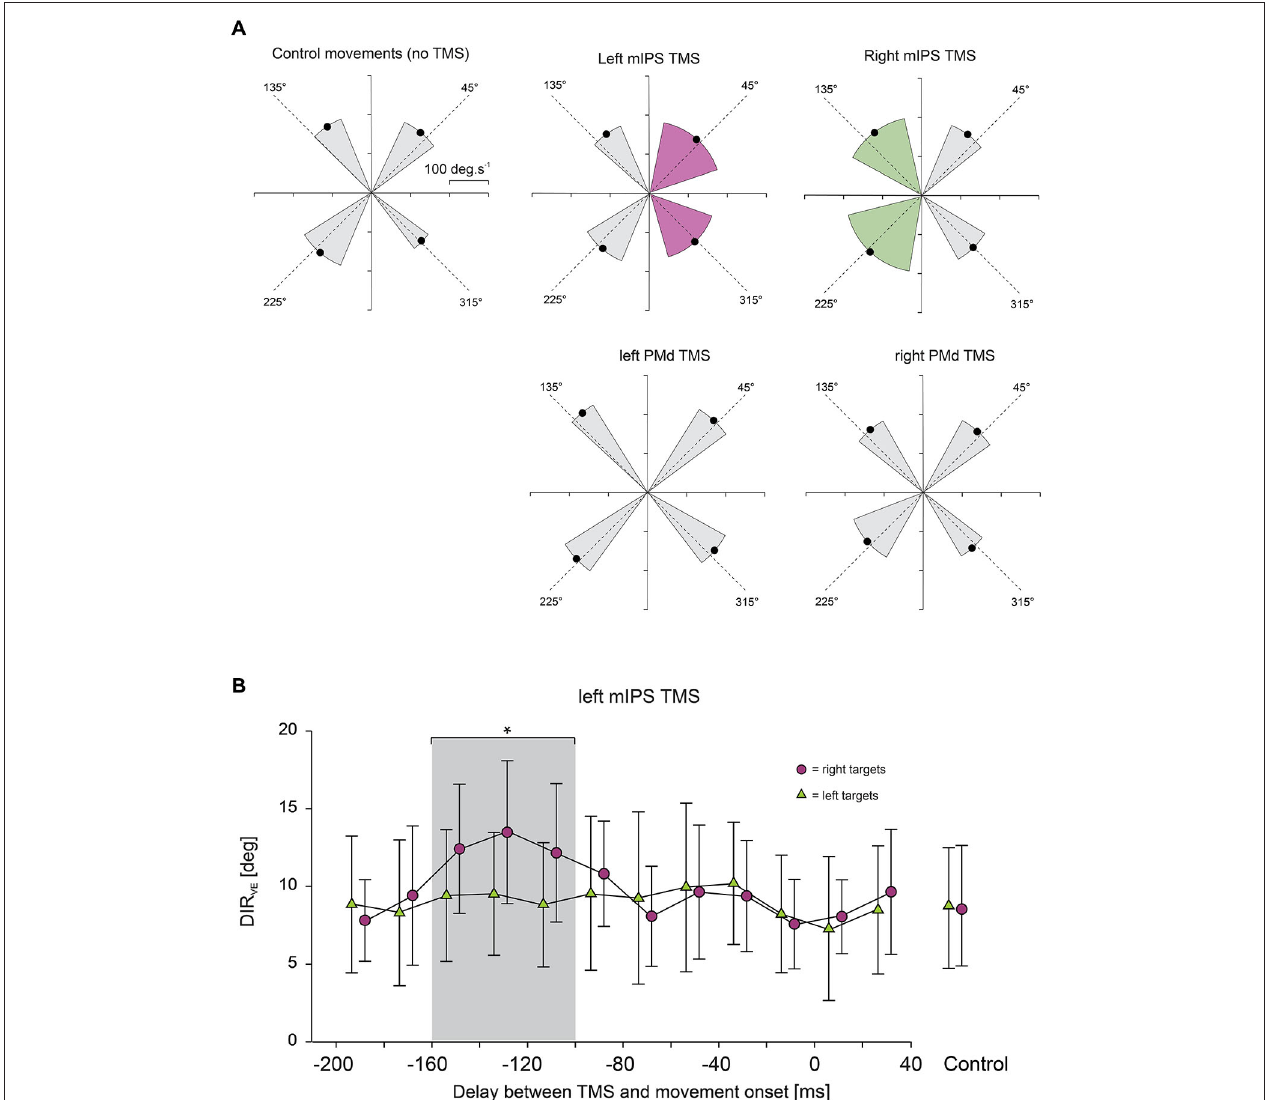
significant effect, namely 160–100 ms). PMd TMS had no effect on the initial movement direction when compared to control (no TMS). (B) Time course of the effects of left mIPS TMS on the initial movement direction (DIR VE ). Data were assigned to bins of 20 ms width (see Methods). X -axis: delay between TMS and movement onset. Y -axis: variable error in the initial movement direction expressed in degrees. TMS over left mIPS increased DIR VE only when applied in a given time window during movement preparation, namely 160–100 ms before movement onset; the gray shading area highlights data points significantly different from control (no TMS) conditions, shown in the right-hand side of the graph. Error bars illustrate ± 1 SD. Results for right mIPS TMS were the same, but only for left targets (not